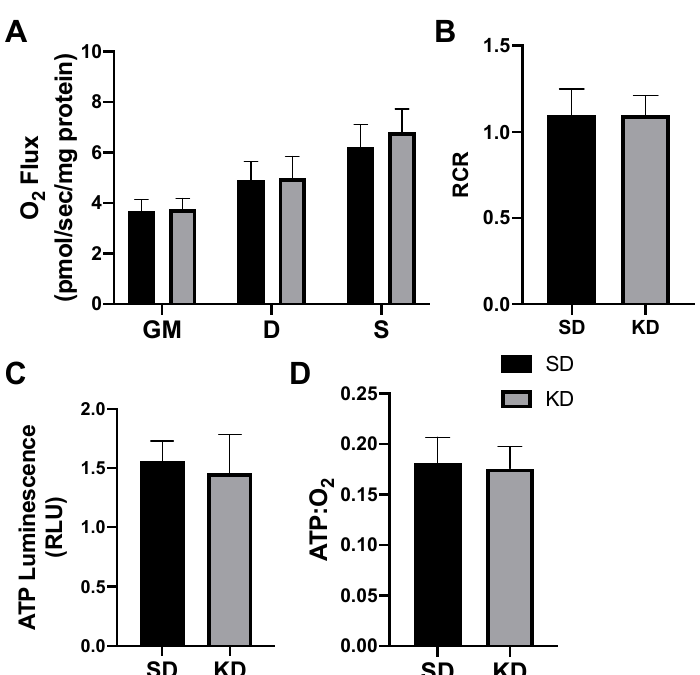
Figure 6. A ketogenic diet does not alter the rodent perirenal adipose mitochondrial bioenergetics. Following the 28-day ketogenic (KD) or standard diet (SD) intervention, perirenal fat was harvested and permeabilized to measure the mitochondrial respiration ( A ) and respiratory control ratio (RCR; B ). ATP was measured via luminescence from fresh tissue ( C ), and the ratio of ATP and oxygen respiration was quantified ( D ). n = 6.